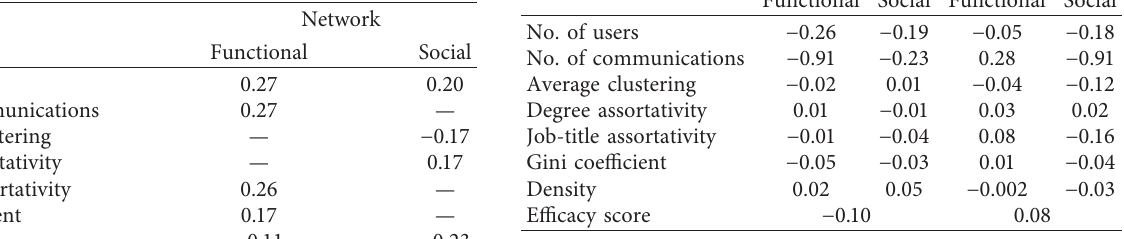
Table 2: Correlation coefficients of functional and social com- munication network features with the efficacy score. Positive co- efficients indicate that the feature correlates with a worse score. Negative coefficients indicate that the feature correlates with a better score. The number of users and that of communications are in the logarithmic scale. Correlations coefficients are significant ( p < 0 . 001). Not significant coefficients are not shown.